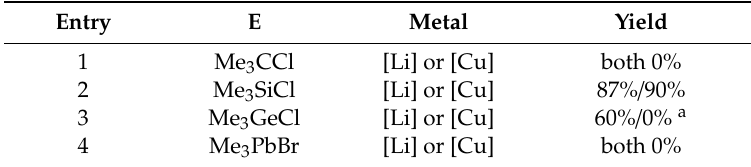
Table 5. Transmetalation of di-stannylated azobenzene 8 with methyl lithium or further metalation to the cuprate and the reactions of these organometallic reagents with electrophilic trimethyltetrel species.